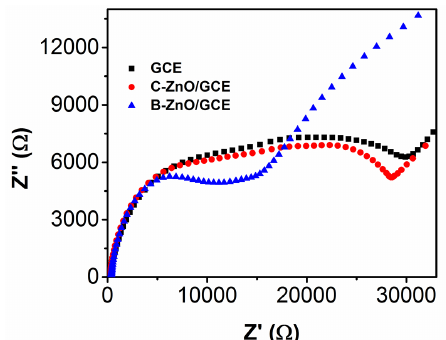
FIGURE 1 - Scanning electron microscopy image of biosynthesized ZnO nanoparticles using Corymbia citriodora leaf extract .